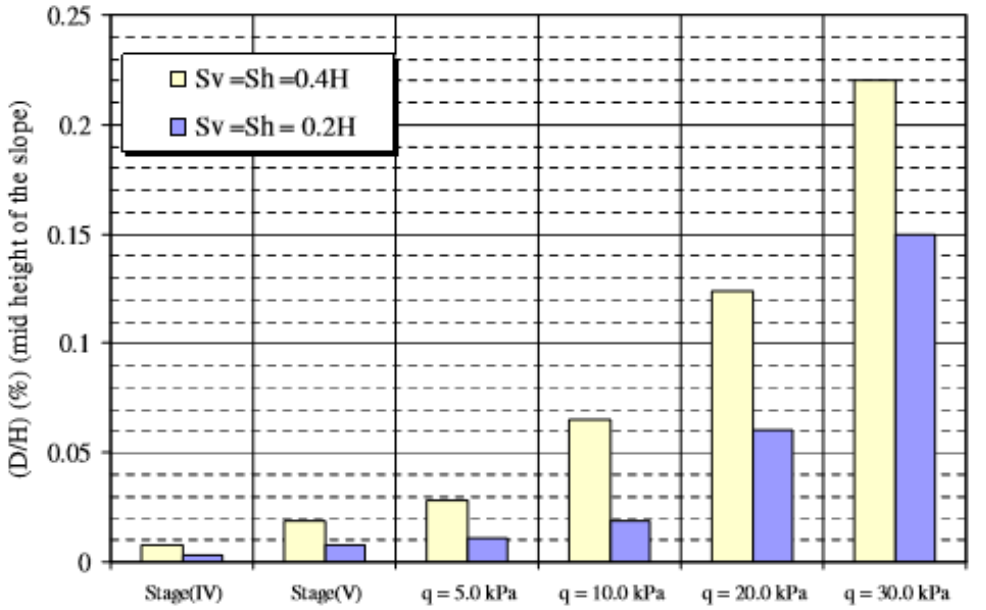
Figure 22. Influence of nail spacing on the horizontal movement at mid height of slope.